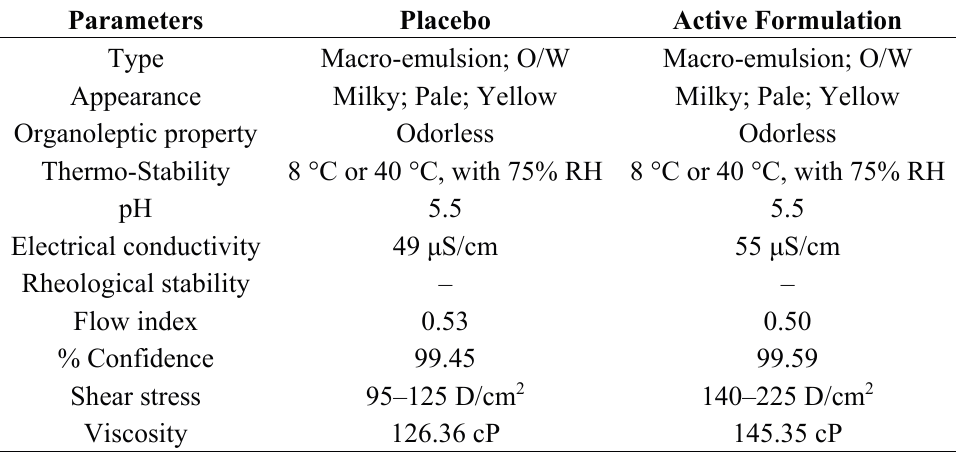
Table 2. Physico-chemical characteristics of the emulsions. O/W: oil/water emulsion; RH: relative